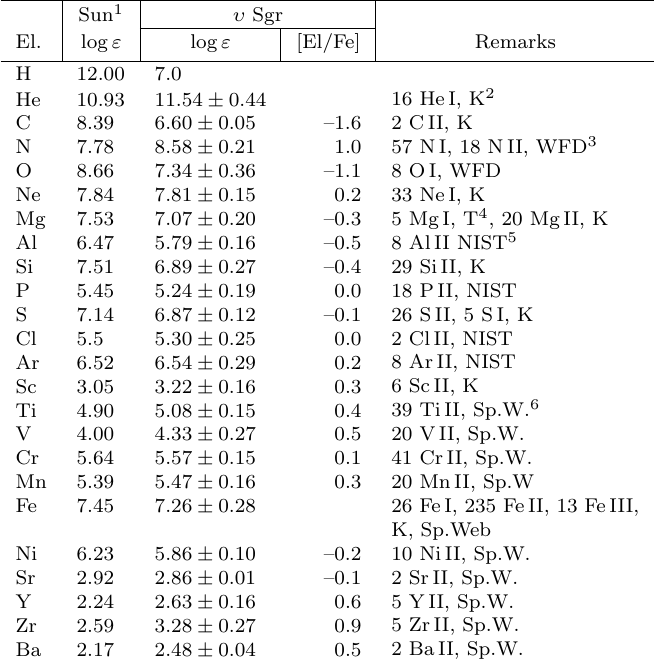
Table 2. Chemical composition of υ Sgr. The abundances are normalized so that log (cid:6) µ i ε ( i ) = 12.15. In the Remarks the number of used lines and the source of oscil- lator strengths are